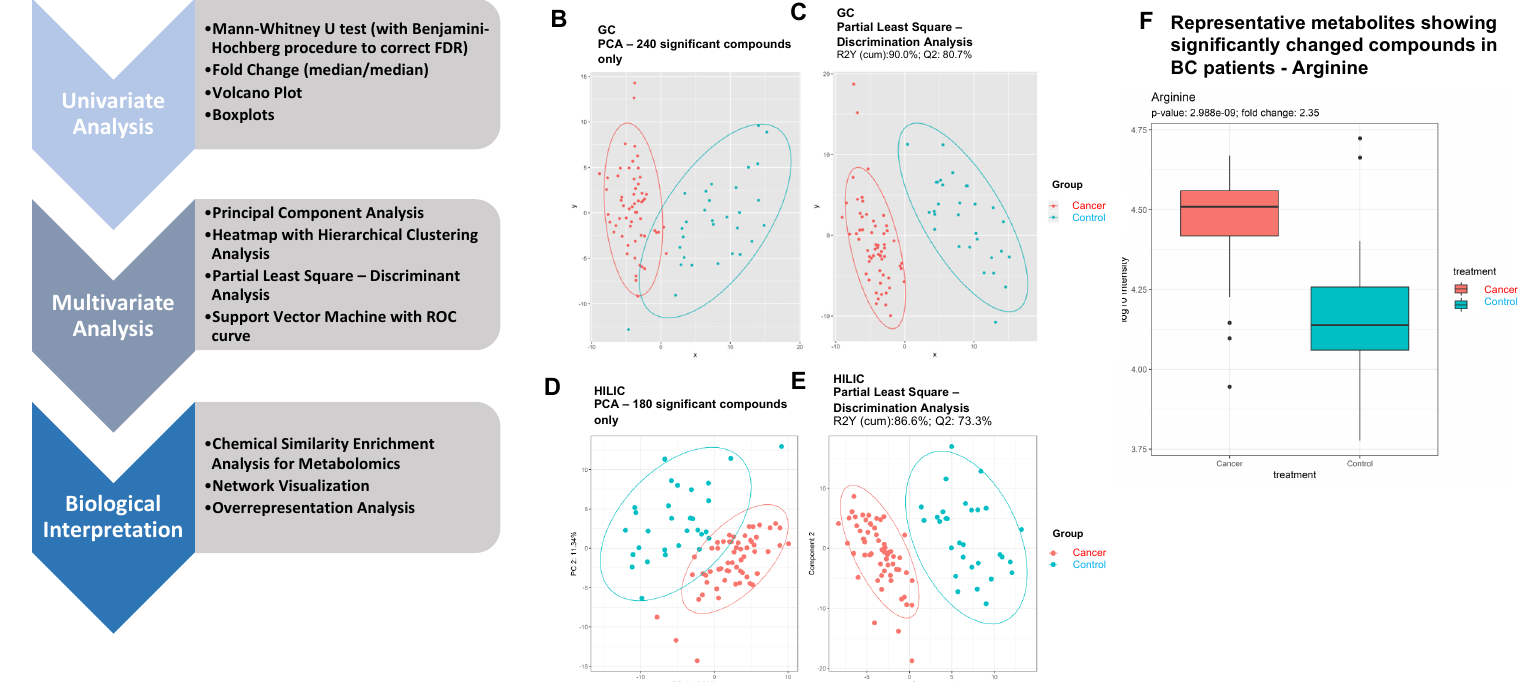
Figure 1. ( A ) Workflow for this study. ( B ) Principal component analysis (PCA) score plot visualization using 240 identified metabolites with Mann–Whitney U test raw p -values less than 0.05 in the GC platform. ( C ) Partial least square–discriminant analysis (PLS-DA) score plot of cancer vs. control. PLS-DA plot shows a clear separation of metabolites between BC patients and controls. Red: control samples; Green: BC patient samples. The model was established using three principal components. Cumulative R2 archived 90.0%, and Q2 achieved 80.7% with permutation test p -values less than 0.05. ( D ) PCA score plot visualization using 180 identified metabolites with Mann–Whitney U test raw p -values less than 0.05 in the HILIC platform. ( E ) PLS-DA score plot on cancer vs. control. Cumulative R2 archived 86.6%, and Q2 achieved 73.3% with permutation test p -values less than 0.05. ( F ) Boxplot of representative metabolite (arginine) showing significant alteration in BC patients.